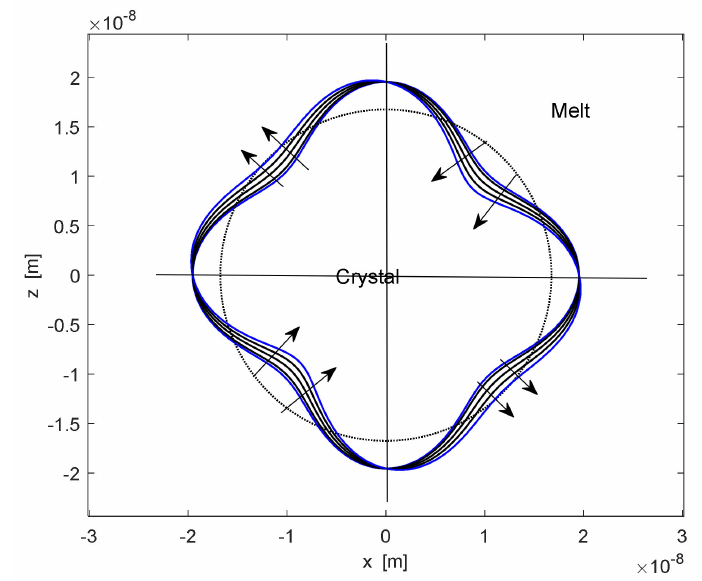
Figure 3. The cross-sectional curves of the interface morphology of the particle under the influence of anisotropic interface kinetics and the shear flow for different shear rates s = 10, 30, 50, 70 at the time t = 7.0, where β = 0.25, r 0 = 1.1 R ∗ , Γ = 0.4545, ∆ T = 10. By contrast, the dashed line denotes the interface without the anisotropic effect of interface kinetics and the shear effect of the